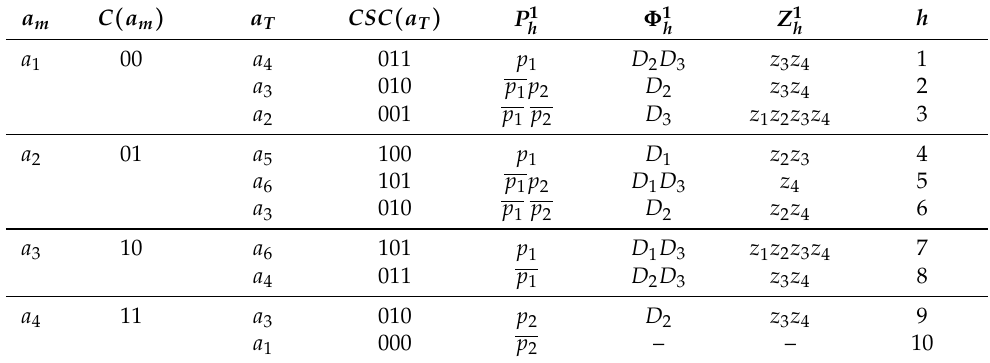
Table 4. Table of LUTer 1 of Mealy FSM MP C Y ( S 0 )